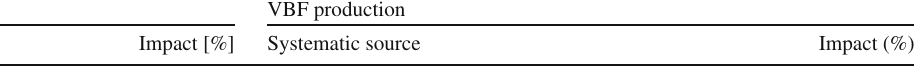
expected upper limit, expressed as a percentage of the signal yield for the ggF (left) and VBF (right) production modes at m H = 300, 600,